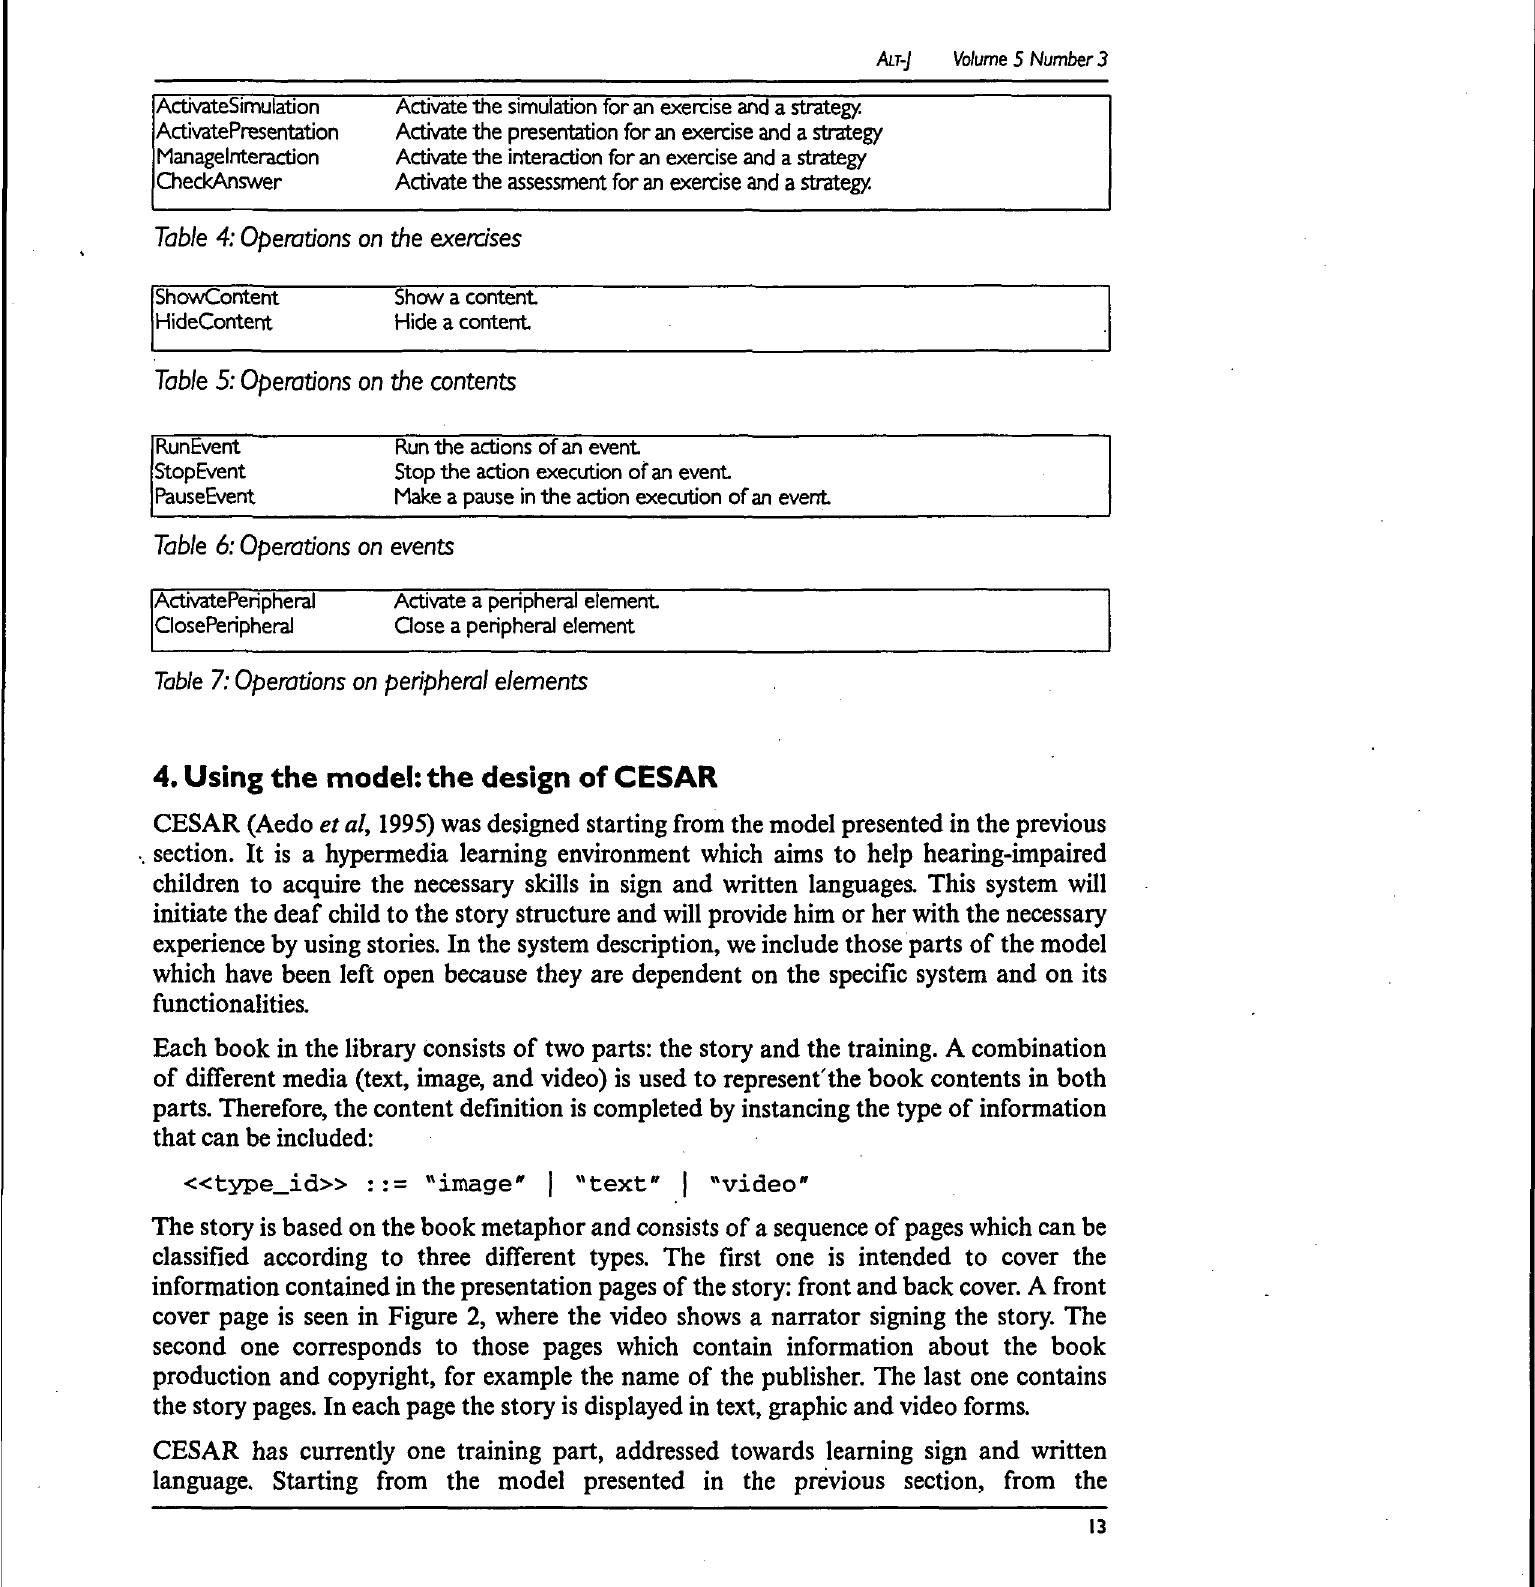
Table 4: Operations on